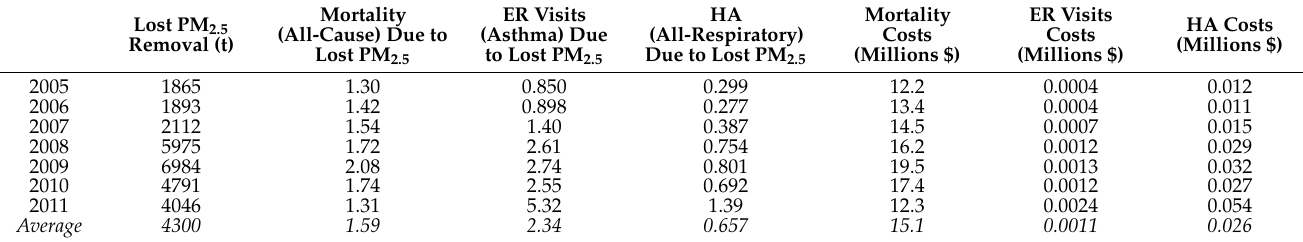
Table A2. Aggregate MPB air pollution and human health impacts with limited PM 2.5 pollution removal. Lost PM 2.5 Removal